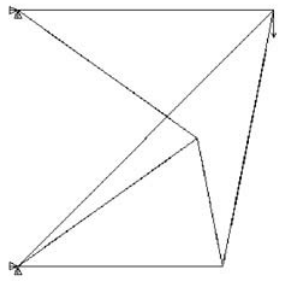
Fig. 3. The global solution of 5-node truss system